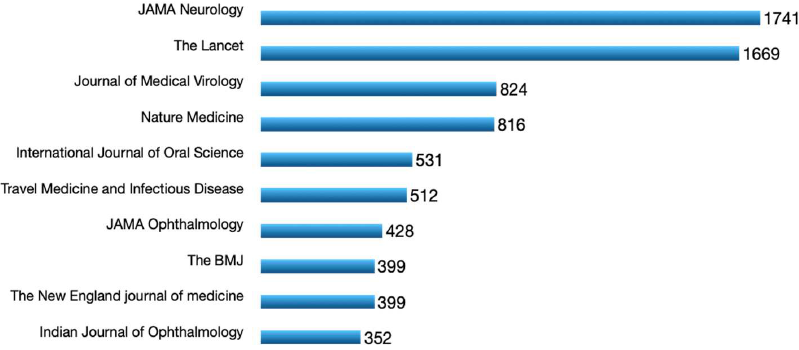
Figure 4. Top 10 cited sources of eye-related COVID-19 literature .